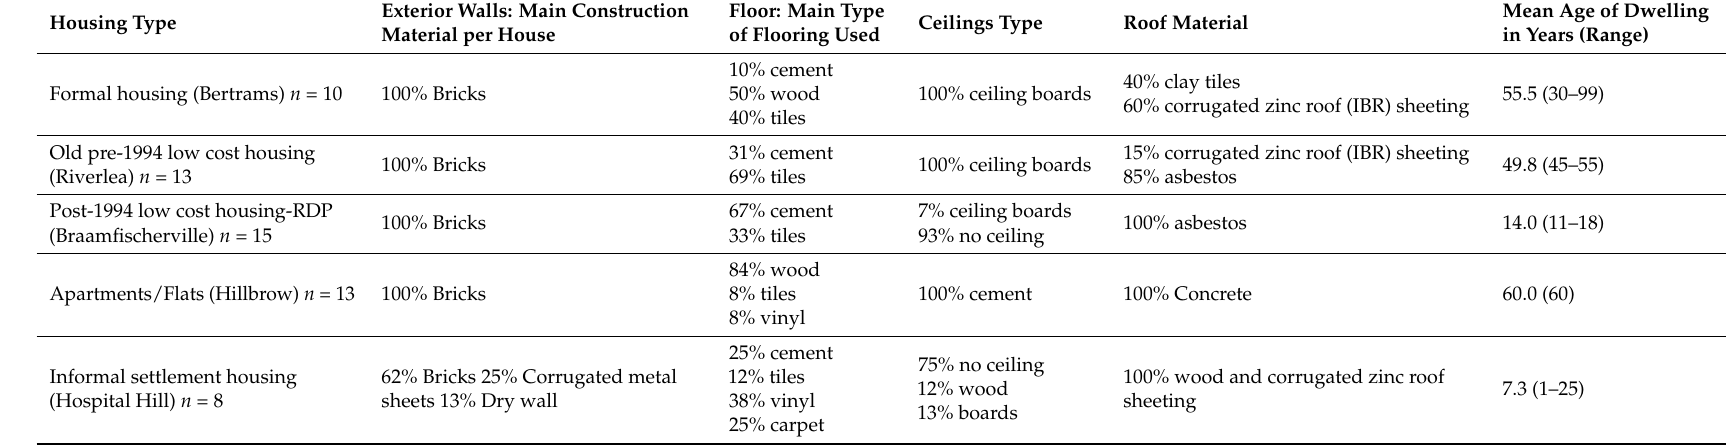
Table 2. Building materials per housing type in the five different study sites according to respondents’ self-reported housing